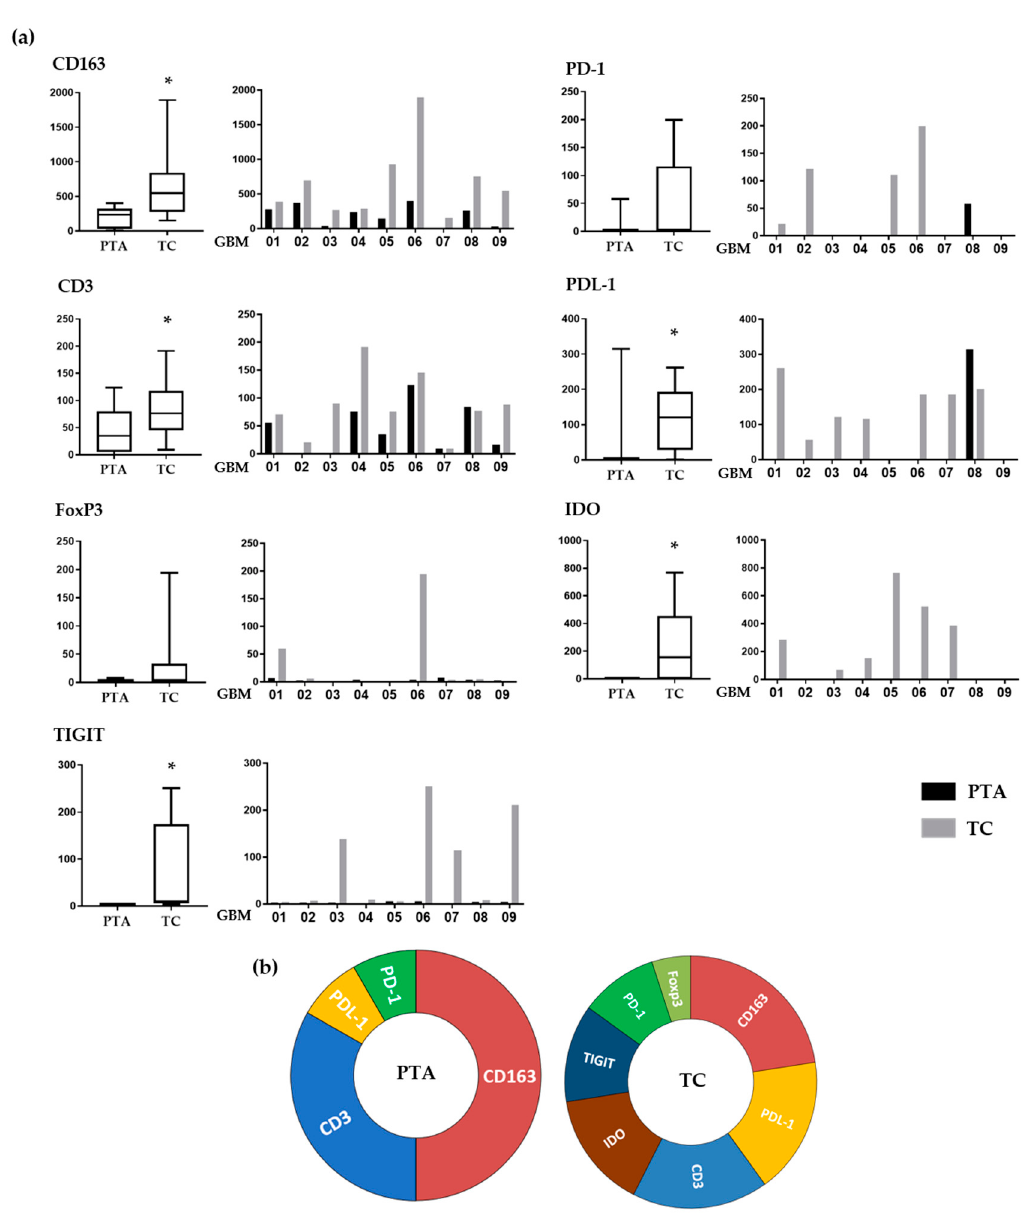
Figure 3. Immune subset distribution in peritumoral area (PTA) and tumor core (TC) of GBM samples. ( a ) IHC values associated with immune markers in the periphery or tumor core depicted for each immune marker. IHC values were obtained by combining the staining intensity and positive area present in the sample tissue area analyzed with the ImageJ software and are reported as arbitrary units ( y axis); *, p < 0.05. ( b ) Immune cell subset infiltrating periphery vs. tumor as depicted by pie charts. FoxP3 positivity, indicating the presence of Treg cells, was found only in the TC of GBM01 and 06 samples, while all the PTAs tested were